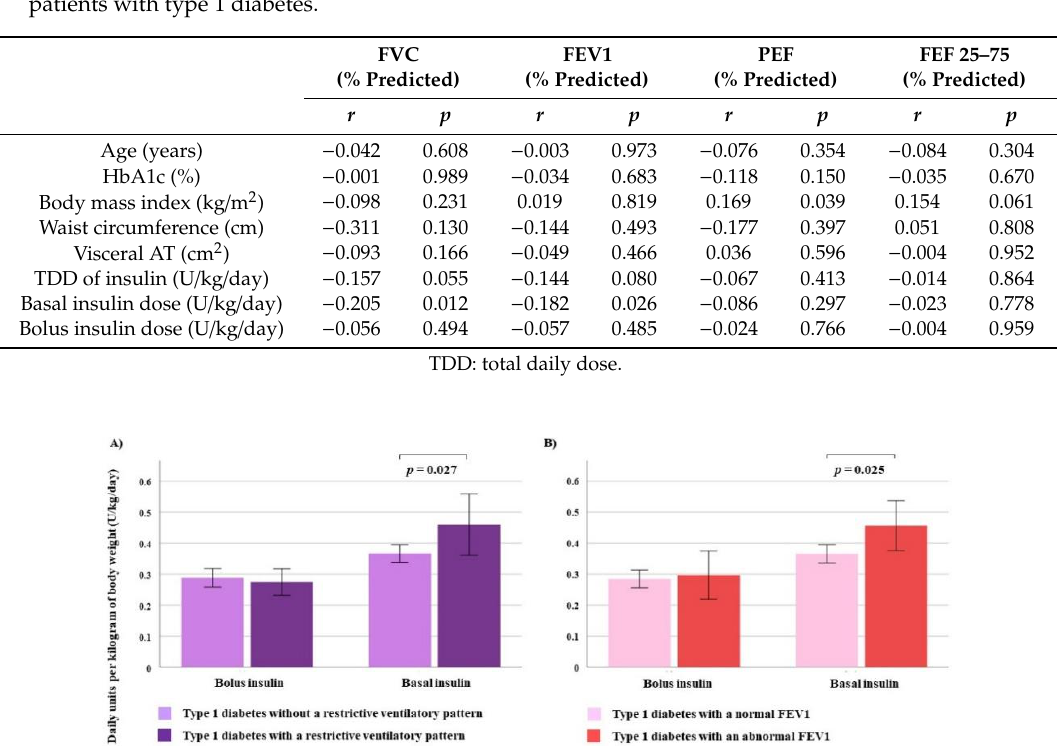
Figure 2. Plot showing the basal-bolus insulin therapy in patients with type 1 diabetes according to: ( A ) a restrictive ventilatory pattern and ( B ) an abnormal ( < 80% of predicted) forced expiratory volume in the first second.